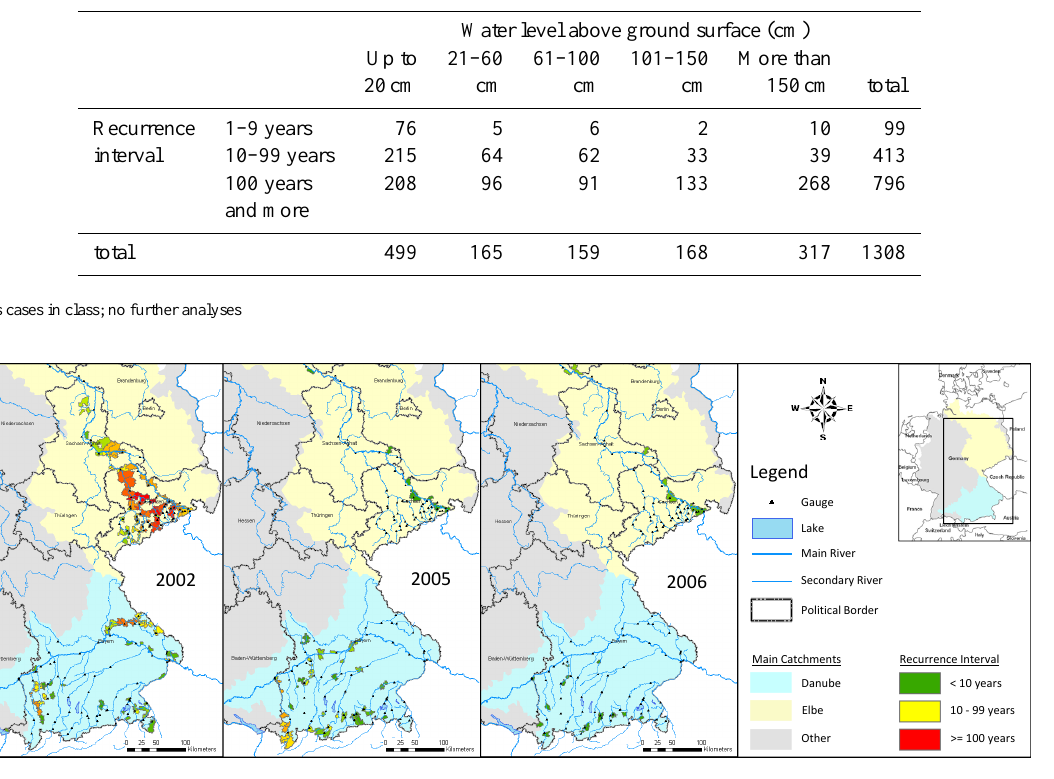
Fig. 3. Recurrence intervals for post code (ZIP) zones with loss